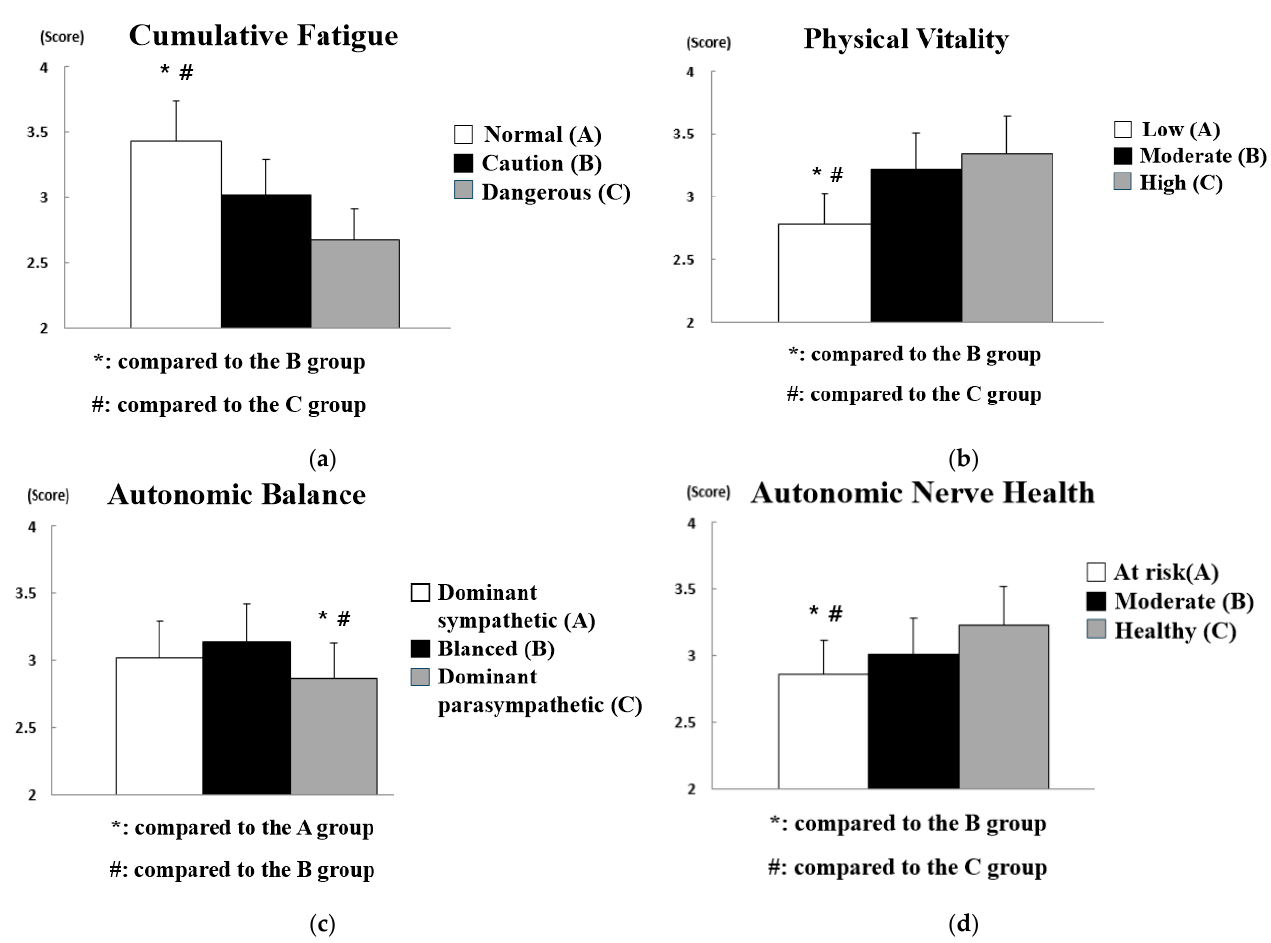
Figure 8. Analysis of differences in safety consciousness according to pulse wave data: ( a ) effect of cumulative fatigue; ( b ) effect of physical vitality; ( c ) effect of autonomic balance; ( d ) effect of autonomic nerve health. Table 7. Statistical analysis results for differences in safety consciousness according to pulse wave